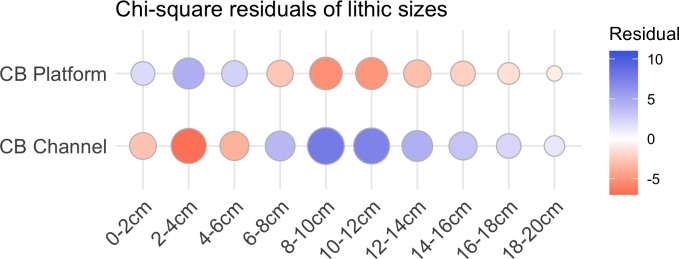
Residual plot for the chi-squared test of artefact sizes from the Cape Bruguieres platform (land) and channel (submerged) assemblages, using the ggcorrplot [64] package in R.Blue circles indicate an over-representation, and red circles indicate an underrepresentation.